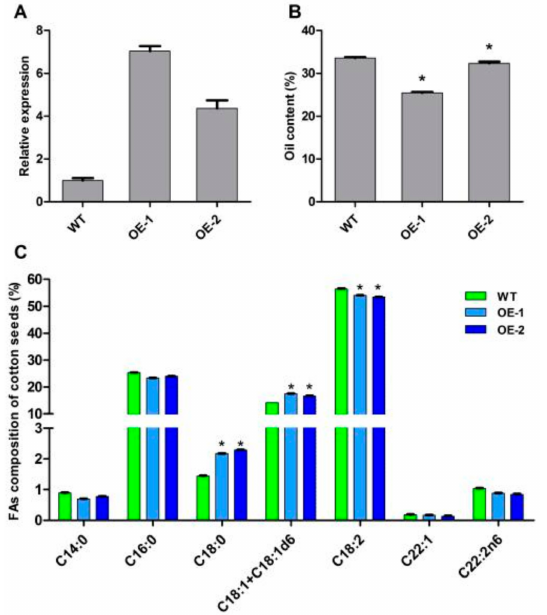
Figure 7. Overexpression of GhCIPK6 changed the oil content and fatty acid composition in transgenic cotton. ( A ) Real-time qRT-PCR analysis of GhCIPK6 expression in transgenic and wild type (WT) cotton plants. OE-1 and OE-2 were di ff erent transgenic lines; ( B ) cottonseed oil content of transgenic and WT cotton plants. Error bars indicate the standard error. Asterisks indicated significant di ff erences ( p < 0.05, *) between transgenic and WT plants; ( C ) fatty acid composition in cottonseeds of